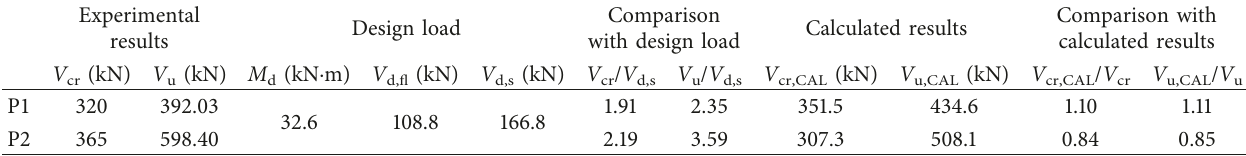
Table 4: Comparison of experimental results with the design load and calculated results.